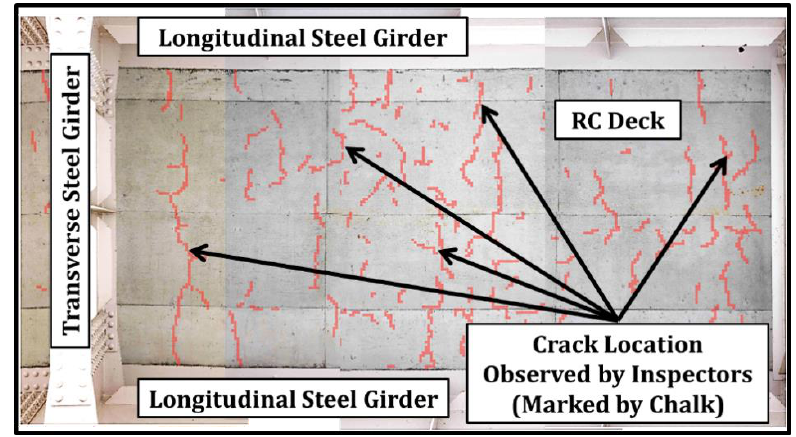
Figure 1. Site inspection for bottom surface cracks of reinforced concrete (RC) decks.